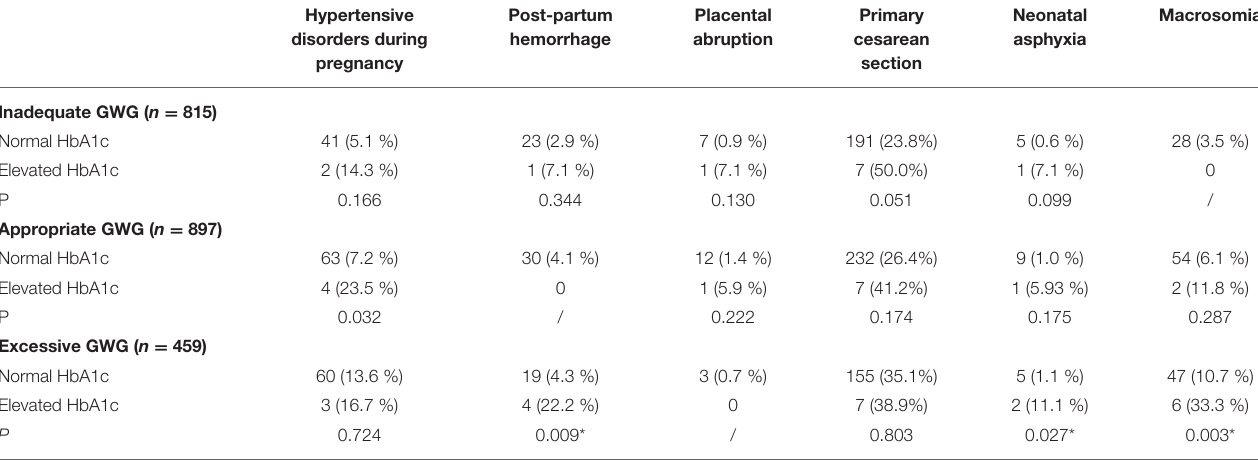
TABLE 4 | Effect of gestational weight gain on the pregnancy outcomes of different groups based on HbA1c levels.